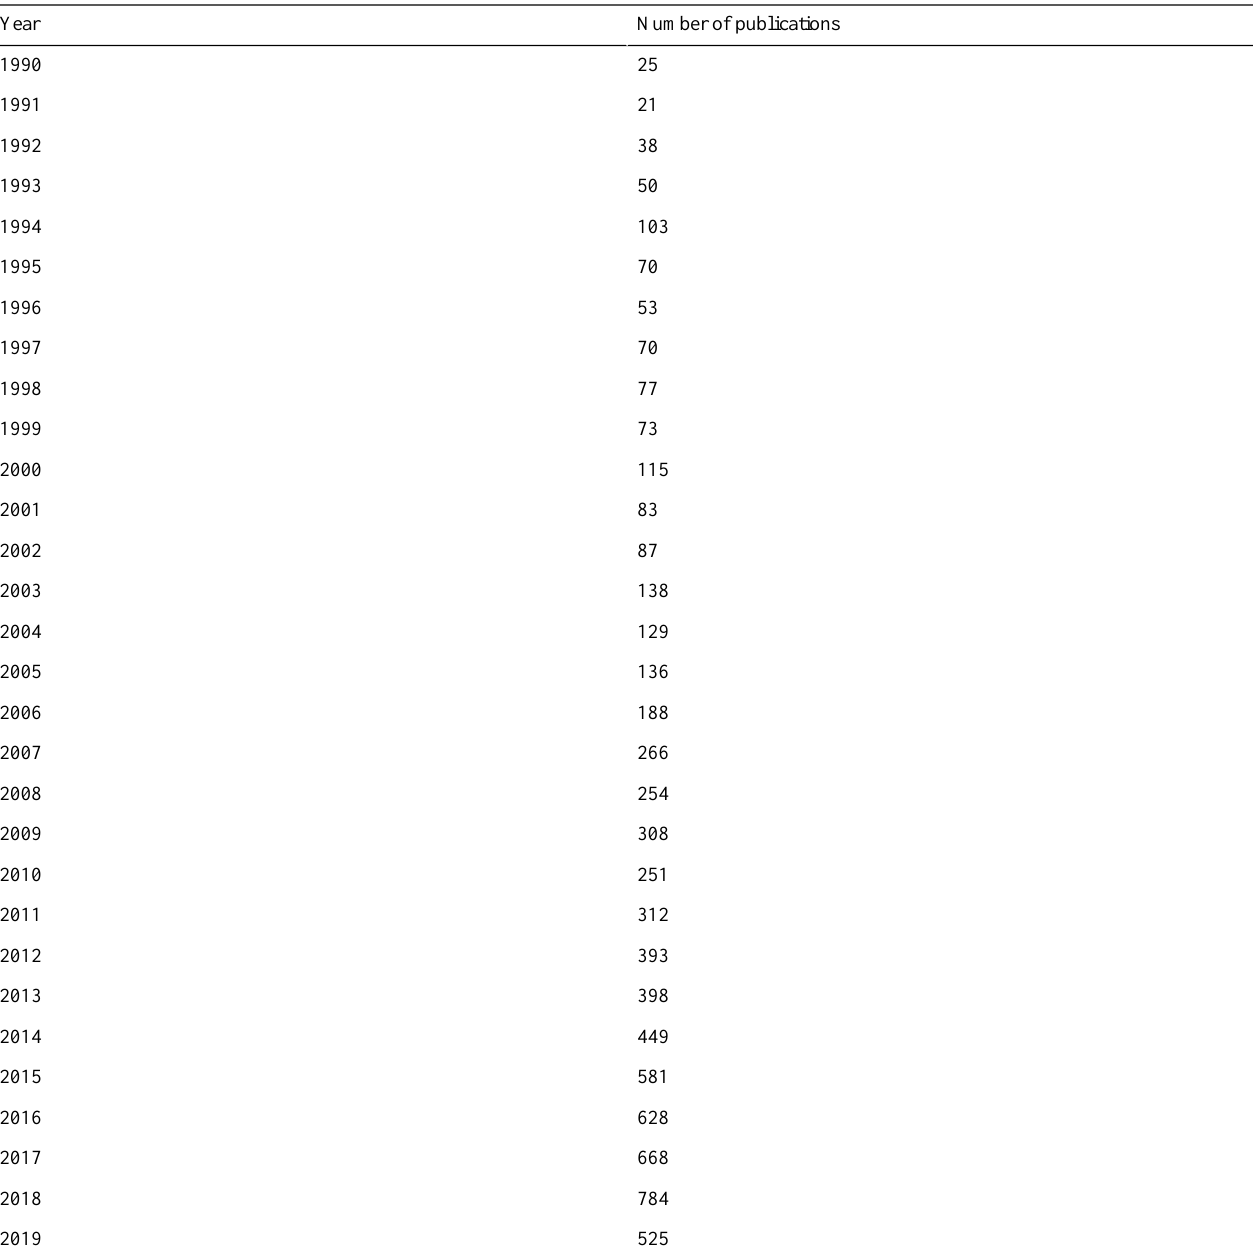
Table 1. Number of publications related to universal health coverage per year, as indexed in Scopus.